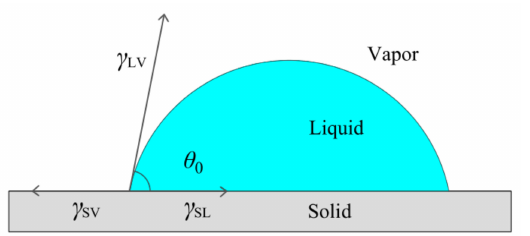
Figure 5. Equilibrium of interfacial tensions of a droplet on a flat surface [63].